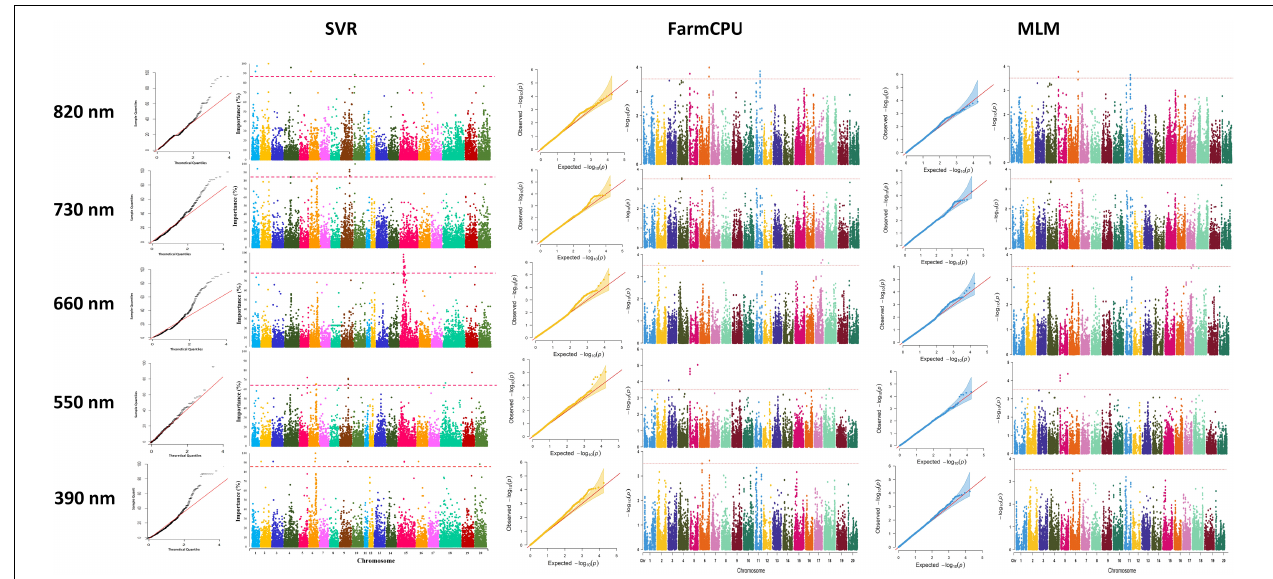
FIGURE 8 | Genome-wide Manhattan plots for GWAS studies of the selected hyperspectral reflectance bands using MLM, FarmCPU, and SVR methods in the tested soybean panel. MLM, mixed linear model; FarmCPU, fixed and random model circulating probability unification; SVR, fixed and random model circulating probability